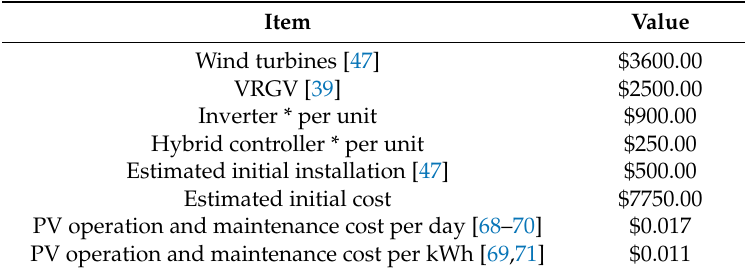
Table 12. Economic parameters of wind power